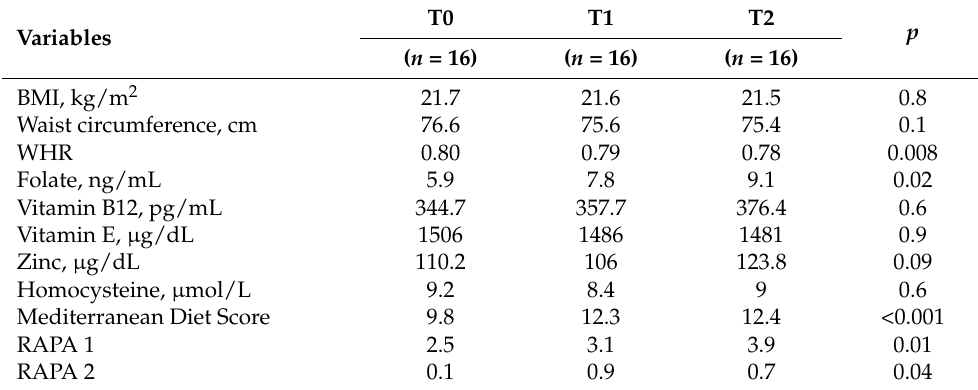
Table 6. Anthropometric parameters, vitamins and lifestyle changes from T0 to T2 ( n = 16).